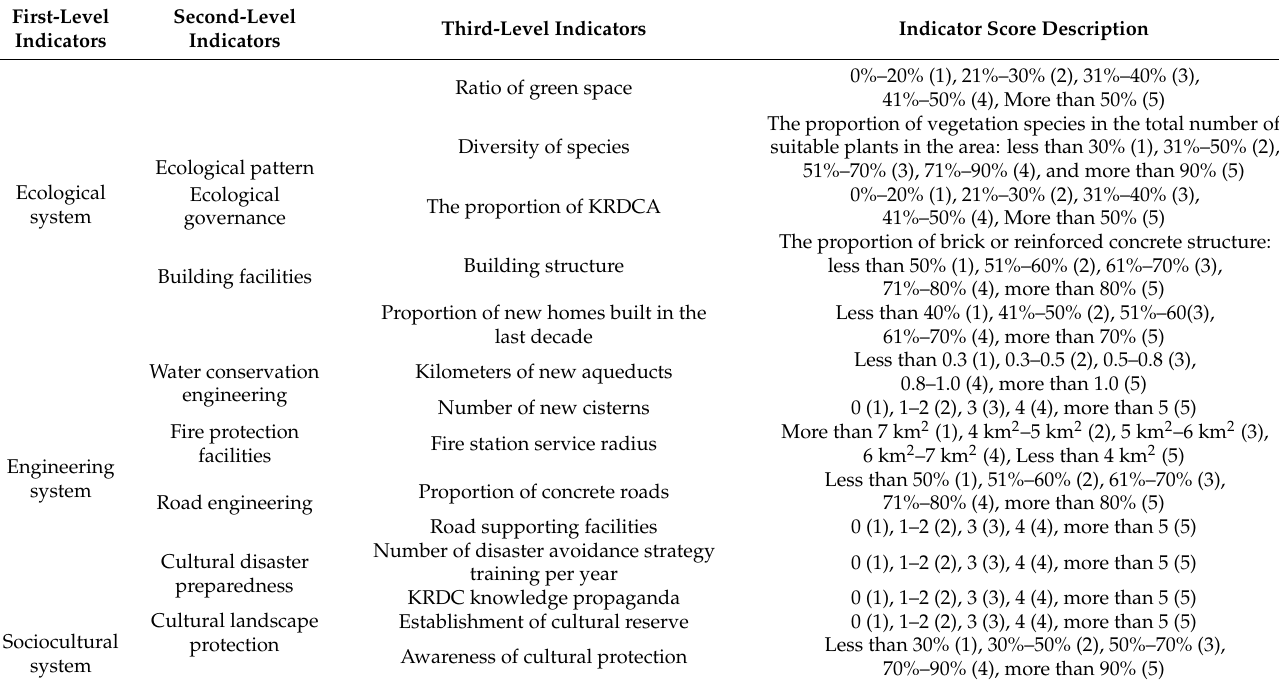
Table 1. Assessment index of disaster preparedness of rural landscapes in KRDCA.